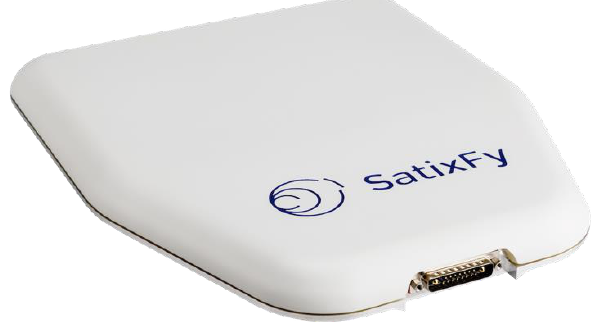
Figure 9. The Satixfy Diamond Ku-band antenna.